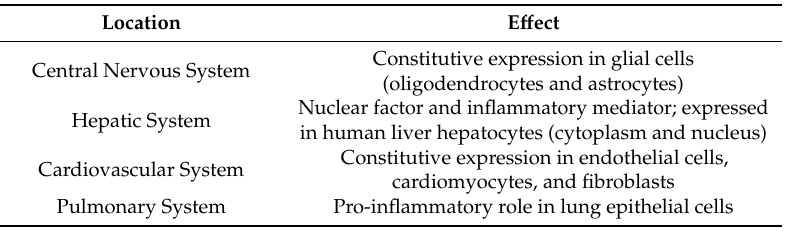
Table 5. IL-33 summary table